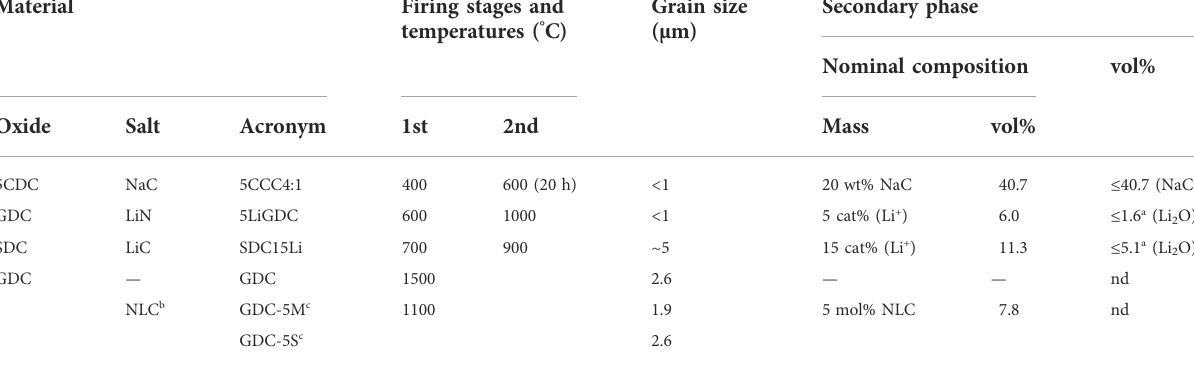
TABLE 3 List of ceria-based solid electrolytes (from top to bottom: Maheshwari and Wiemhöfer, 2016; Zhu et al., 2014; Li et al., 2012; Grilo et al., 2020).